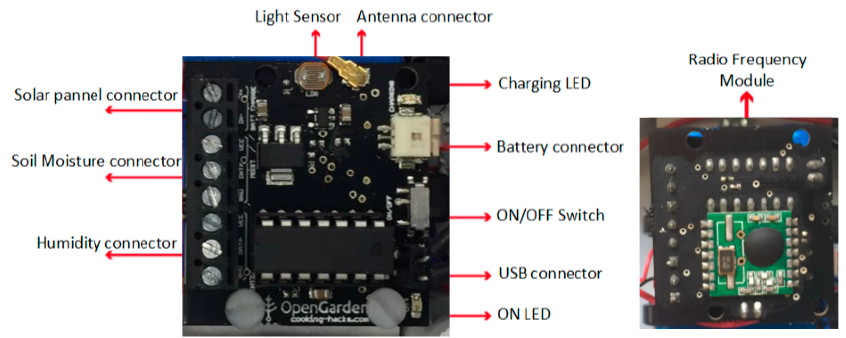
Figure 4. OpenGarden Slave Node functionality board [42].